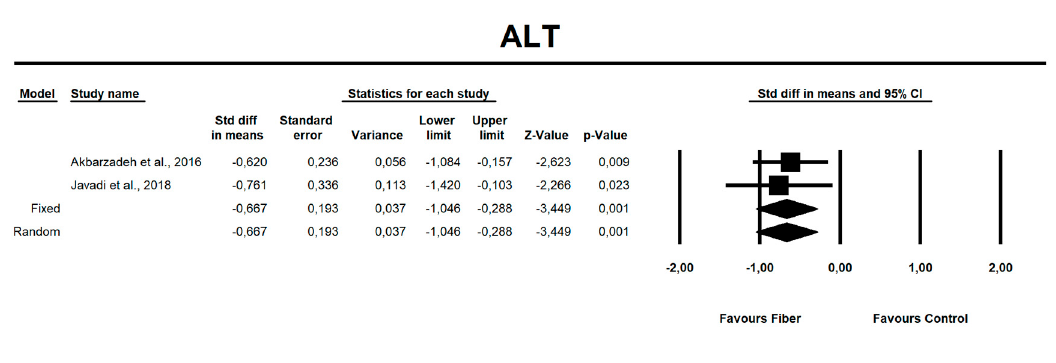
Figure 6. Effect size and standardized mean difference (SMD) for alanine aminotransferase (ALT) in people supplementing fiber vs. controls. Q = 0.118, df(Q) = 1, p = 0.732, I-squared = 0.0.